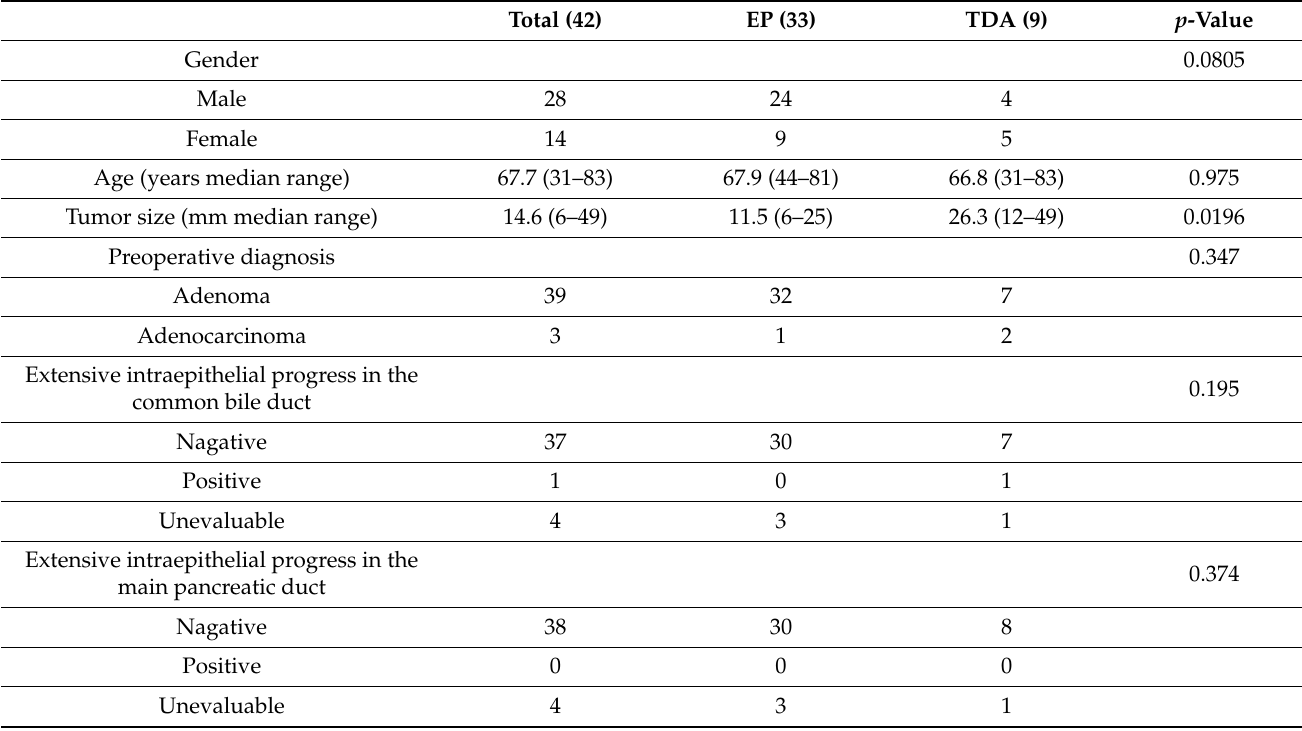
Table 1. Patients’ background characteristics.